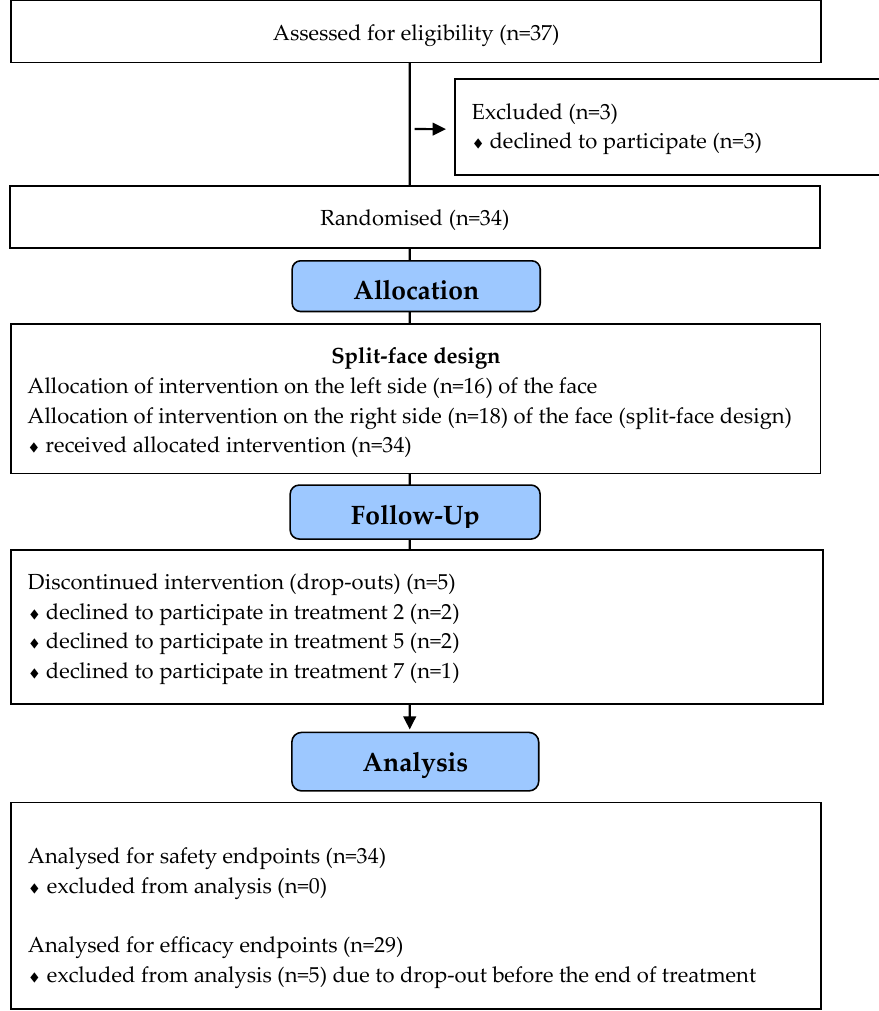
Figure 2. Flow chart diagram.